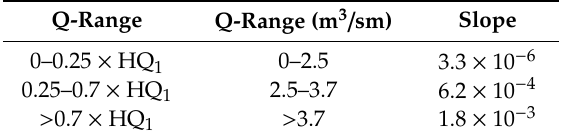
Table 2. Parameters of the tri-linear transport model in 1:1 scale.